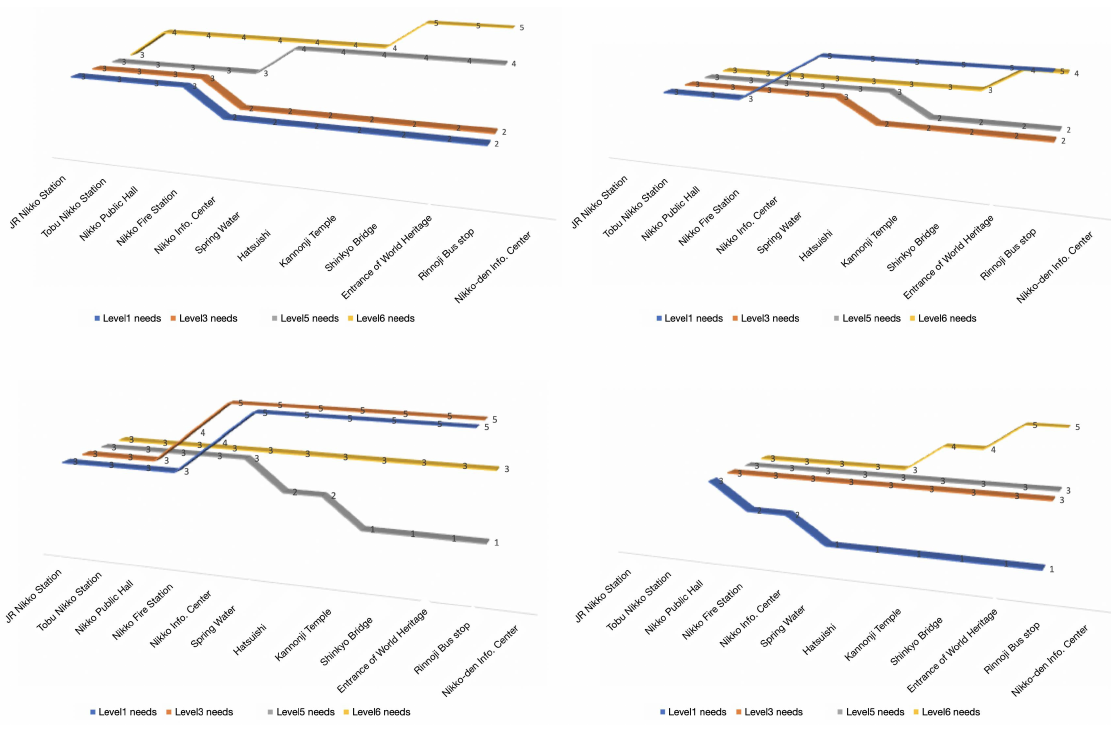
Figure 18. History of changing the value of the reference points: Experiment 1. Table 14. Old parameters to change the value of reference